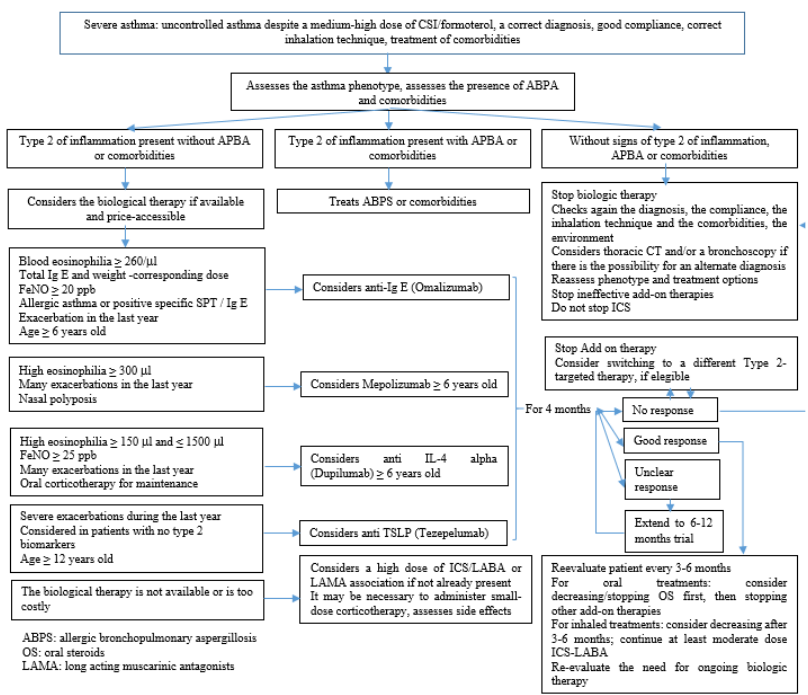
Figure 3. Management of severe forms of asthma adapted to GINA 2022 recommendations and from Recent Advances in Long-Term Management of Asthma (published online ahead of print, 20 January 2022). Indian J Pediatr. 2022 [42].